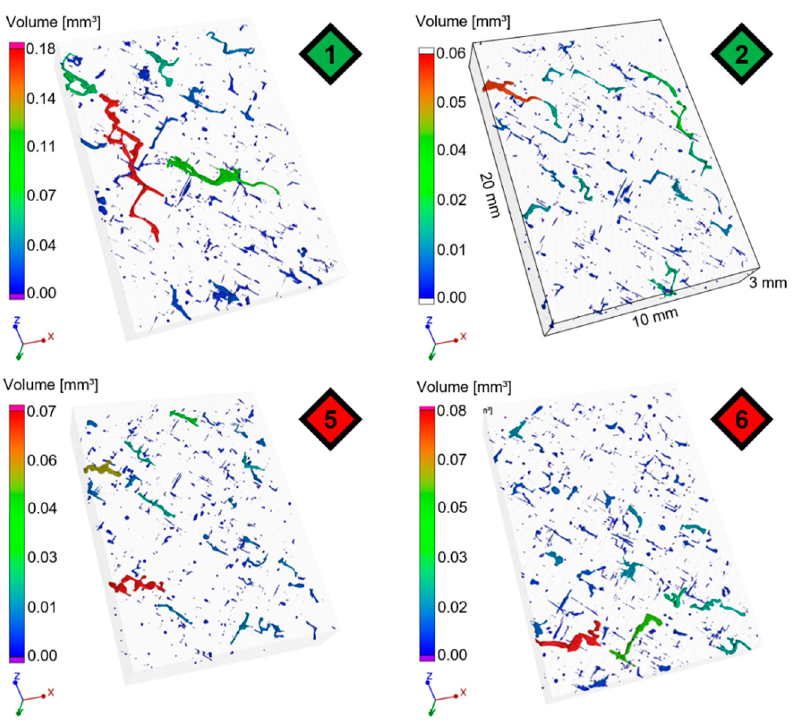
Figure 4. µCT analysis of calculated local pore volume and its distribution in the center area of bending specimen with fiber orientation of ±45°, sample #1 and #2 from homogeneous area, sample #5 and #6 from inhomogeneous area.